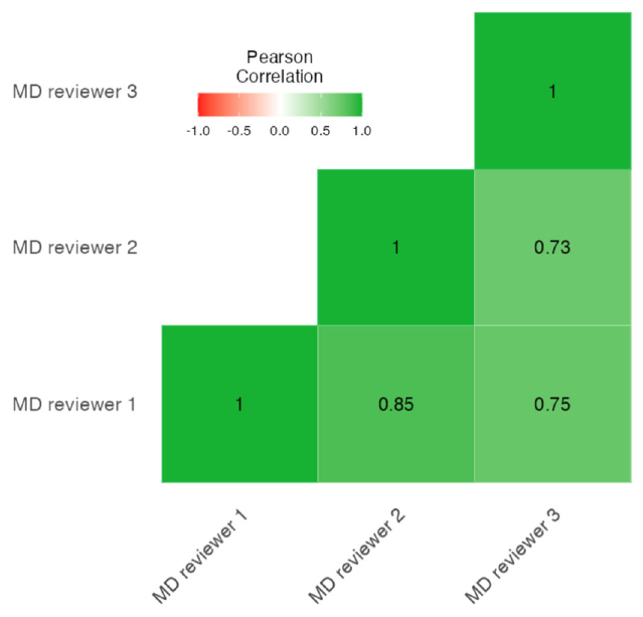
Figure 2. Heat map of the correlation between the MD scores of the three reviewers.